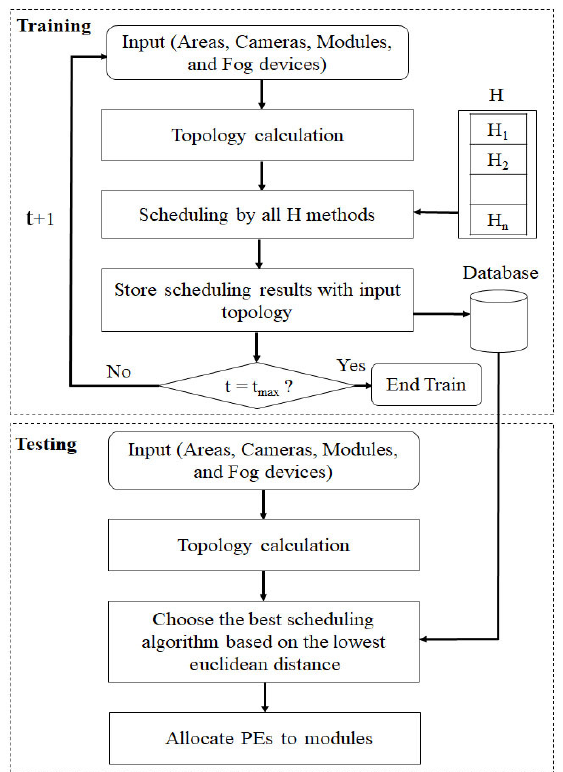
Figure 2. HHS algorithm